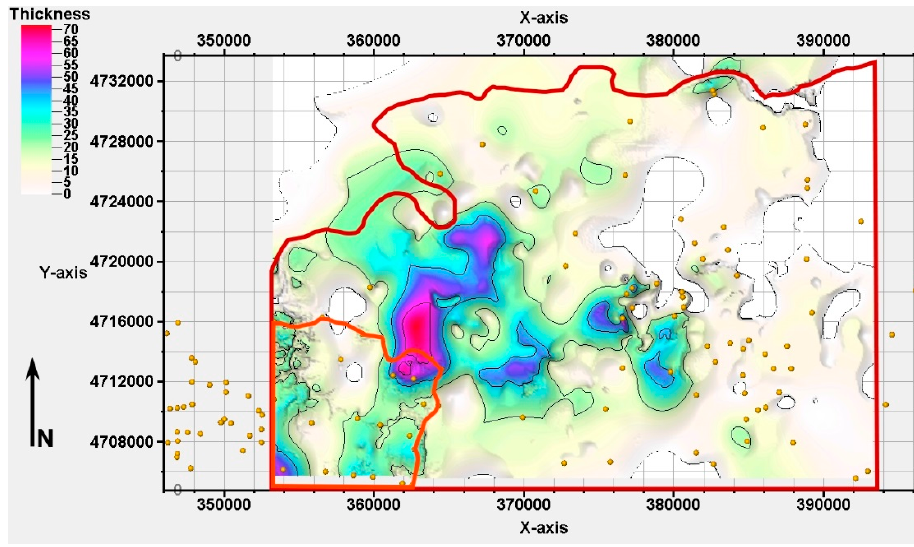
Figure 11. Isopach map of the Walworth Formation undivided. Orange dots represent water-well locations. Thickness is in meters.